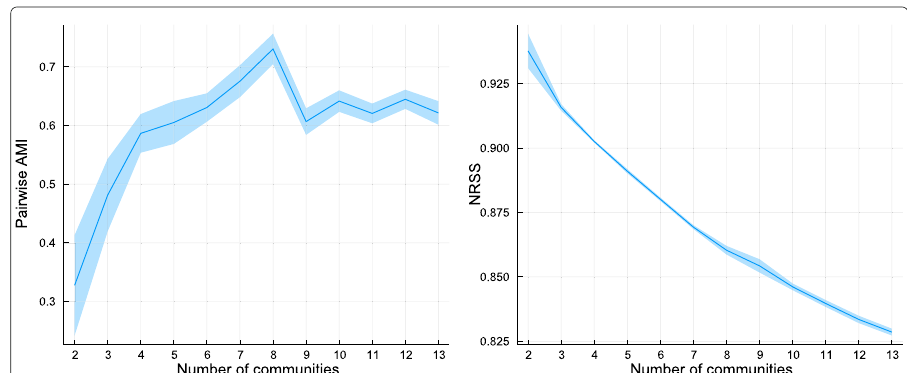
Fig. 11 Choosing the number of communities: CRAN. Left: the mean pairwise adjusted mutual information of the community-node membership across repeated decompositions. 1 is a perfectly stable assignment to communities; 0 is perfectly random. The shaded area corresponds to twice the standard error of the mean. Right: the mean normalised residual sum of squares error for repeated decompositions on the CRAN network against the number of components. The shaded area corresponds to twice the standard error of the mean above and below the line